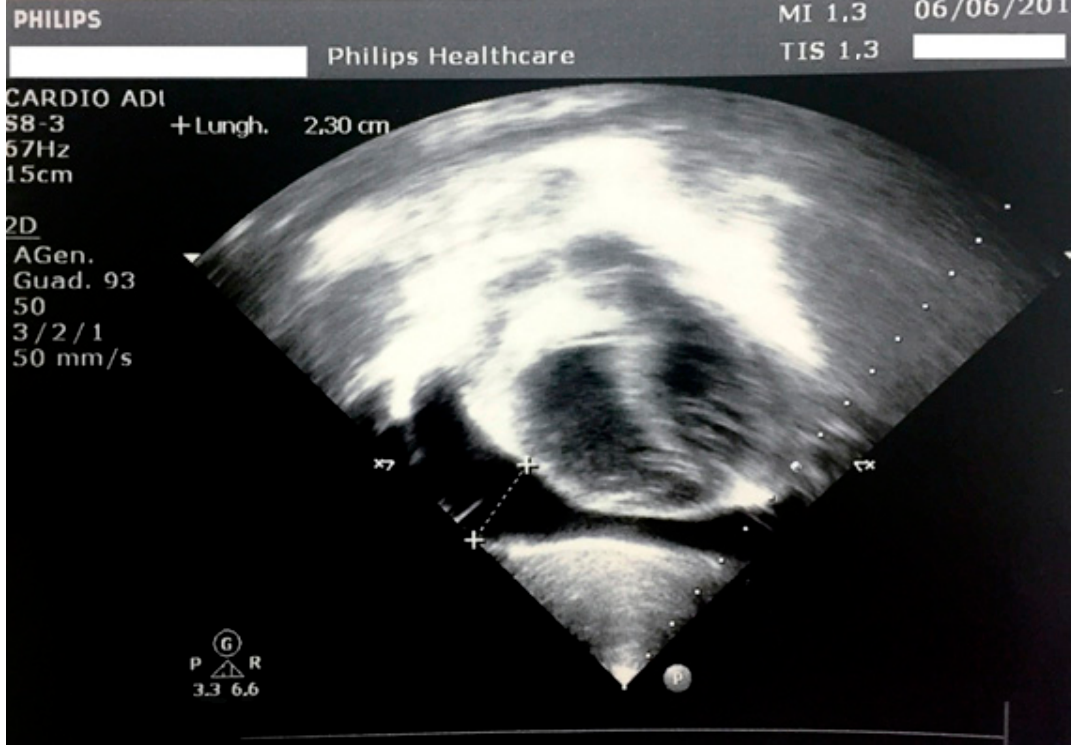
Figure 1. Echocardiography at admission, with evidence of a hyperechogenic pericardium and a large pericardial effusion.